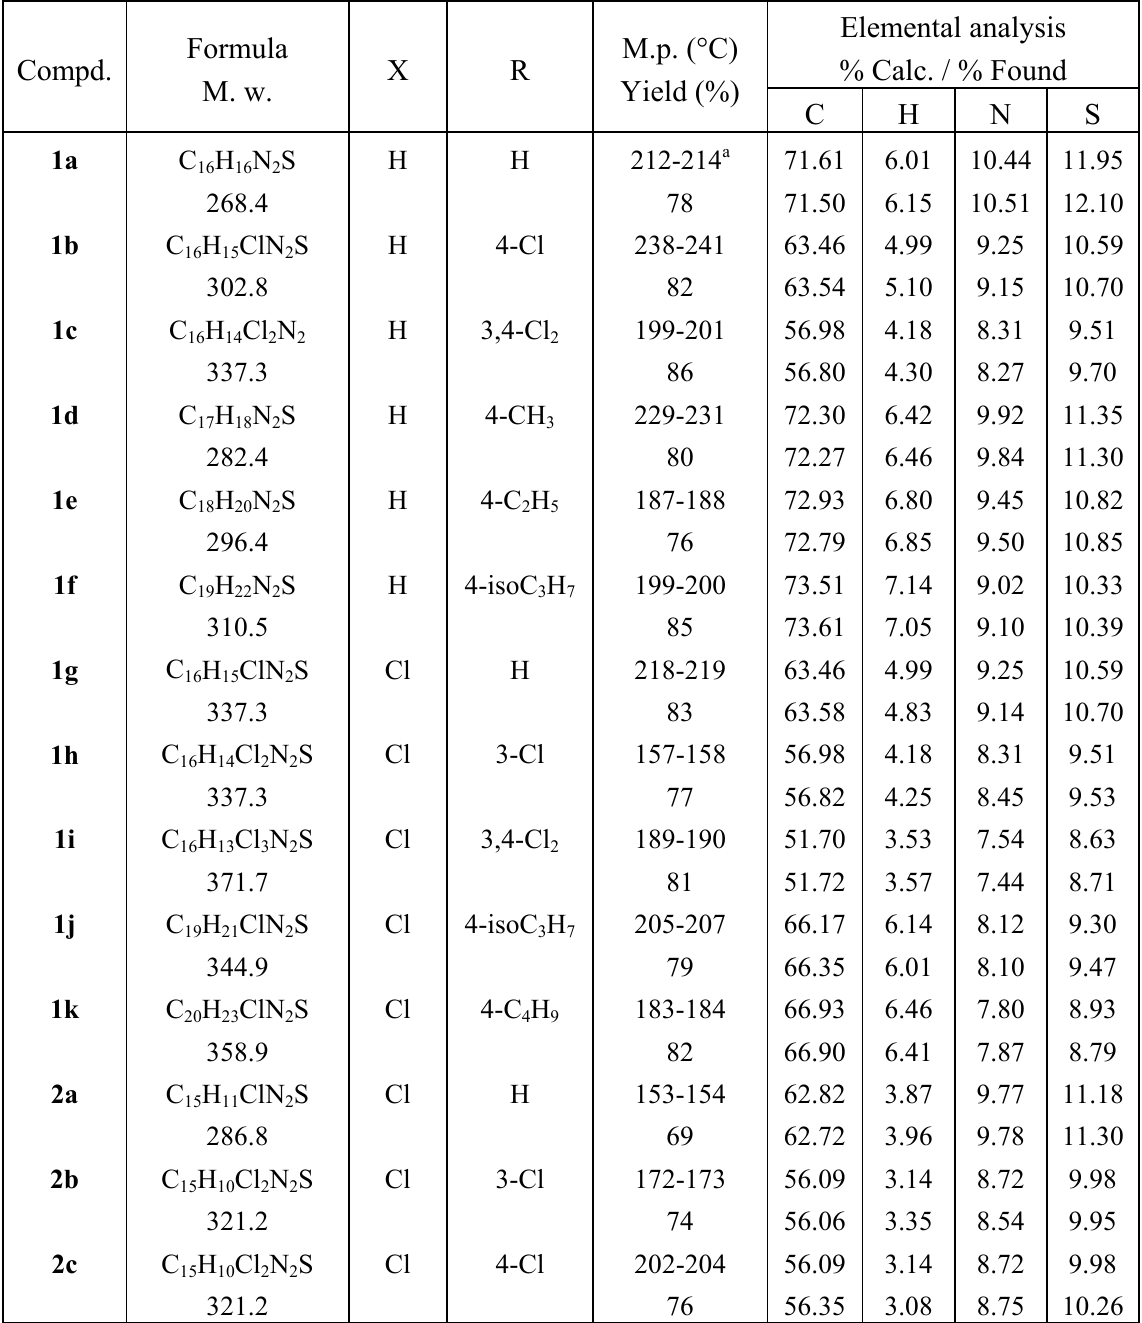
Table 1. Analytical data of 2,2-dimethyl-3-phenyl-1,2-dihydroquinazoline-4(3 H )-thiones ( 1